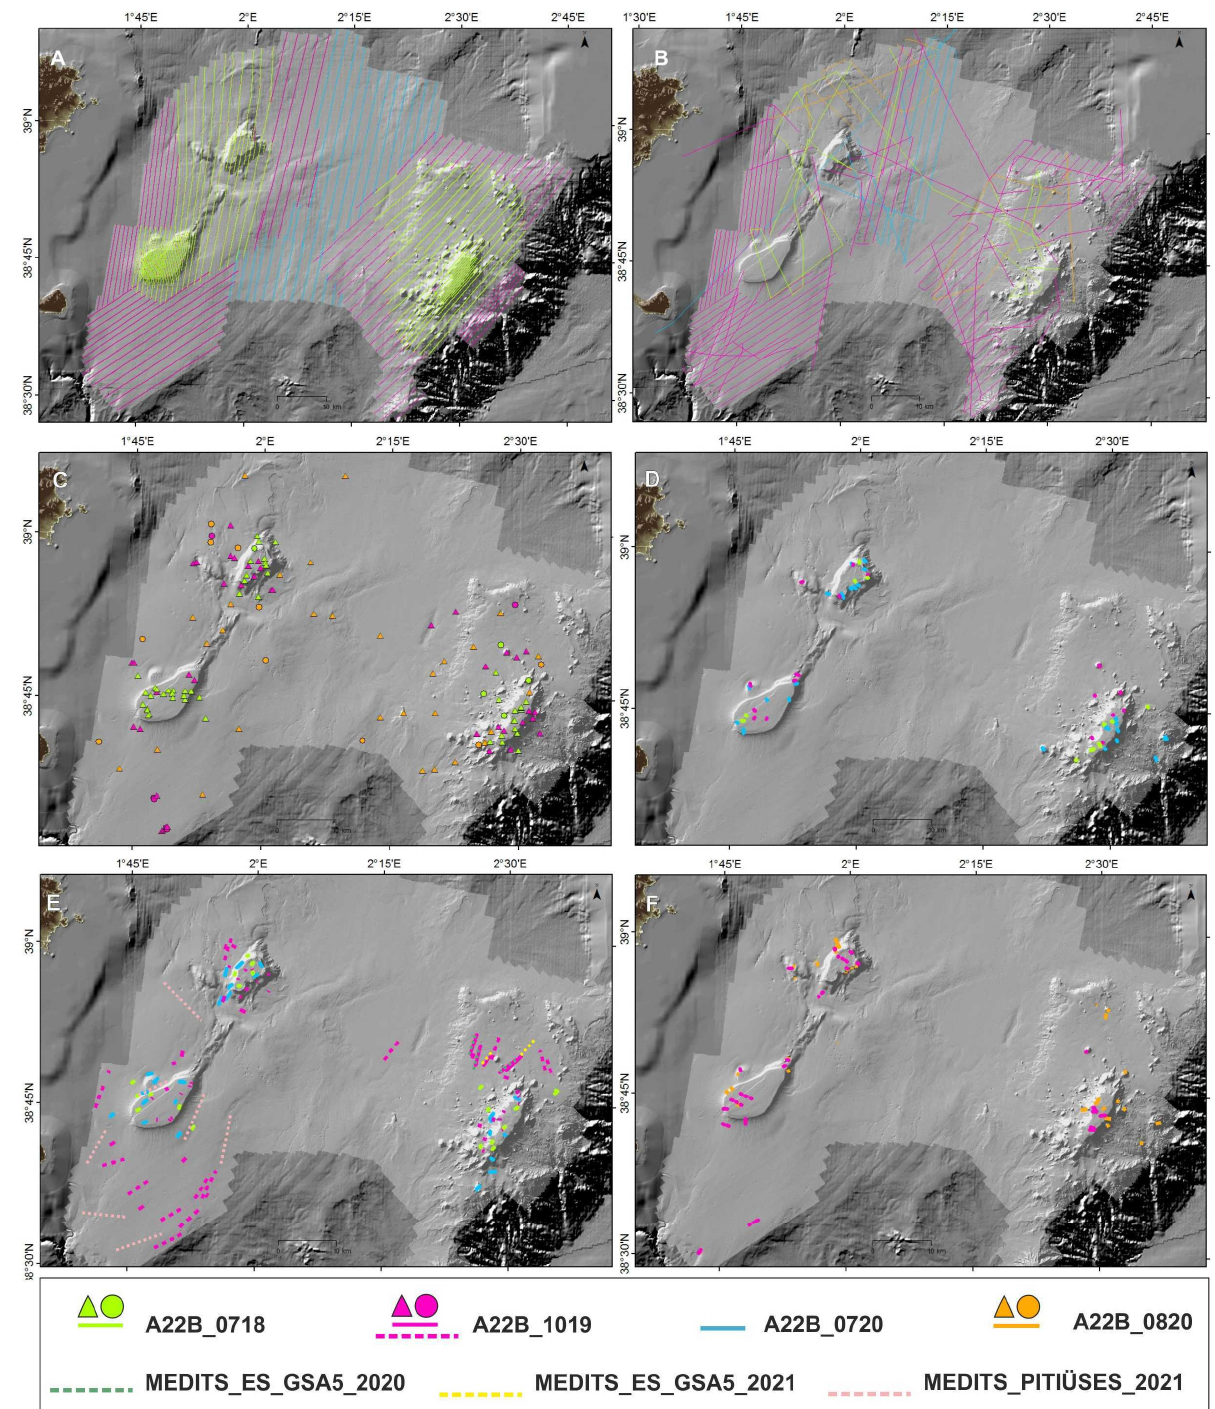
Figure 3. Map of the study area around the Ses Olives, Ausias March, and Emile Baudot seamounts in the Mallorca Channel (Balearic Islands, western Mediterranean) showing the sampling developed in each research survey (plotted in different colors): ( A ) multibeam echosounder; ( B ) high-resolution sub-bottom profilers; ( C ) Box–Corer in circles and Shipek in triangles; ( D ) rock dredges; ( E ) beam trawl (continuous lines) and GOC (dashed lines); and ( F ) ROTV (dashed lines) and ROV (continuous lines).